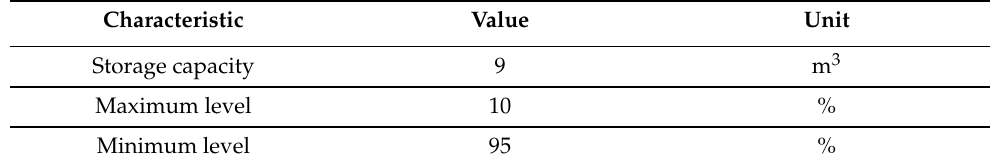
Table 5. Technical specifications of the hydrogen storage